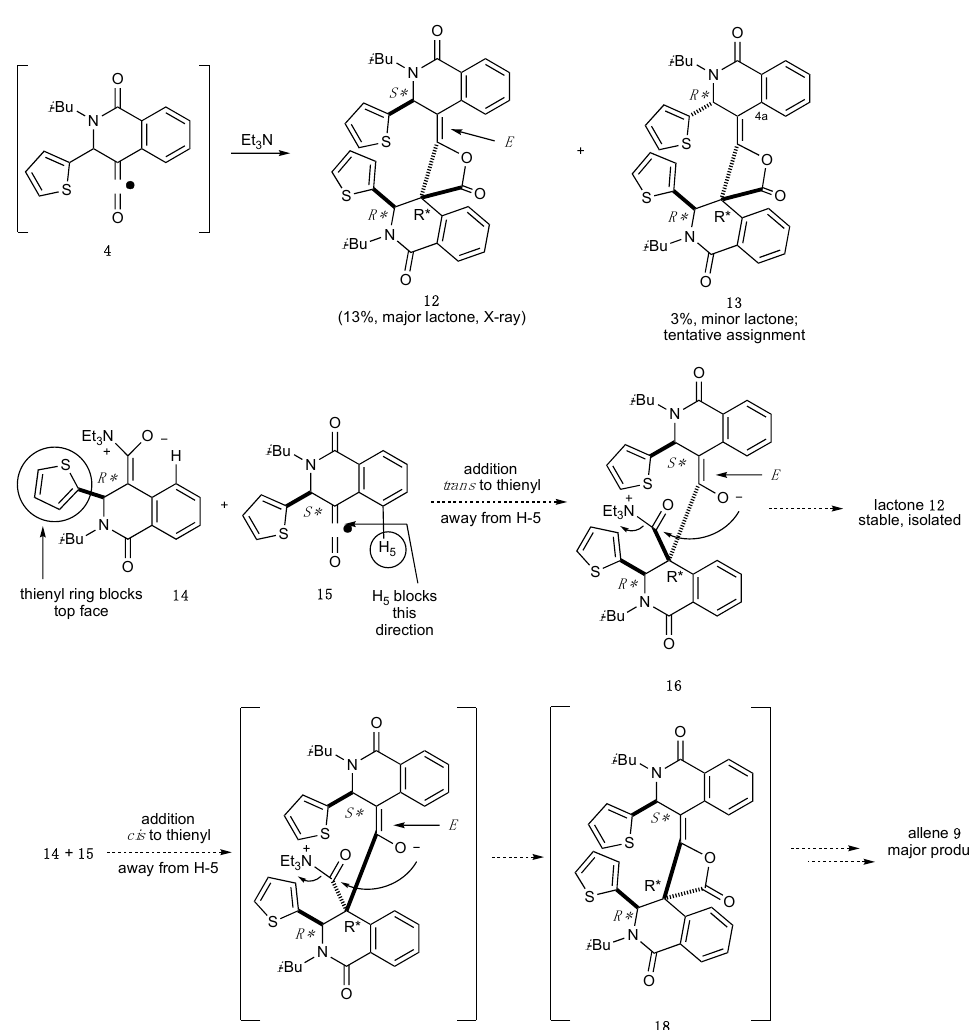
Scheme 2. Formation of major dimeric products from ketene 4 . The star (*) indicates the relative stereochemistry in a racemic context. stereochemistry in a racemic